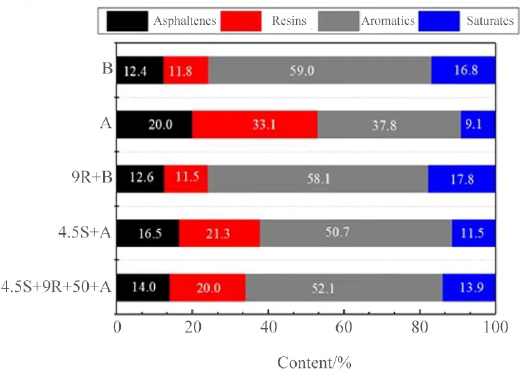
Figure 6. Percentage of four components of different types of asphalt.